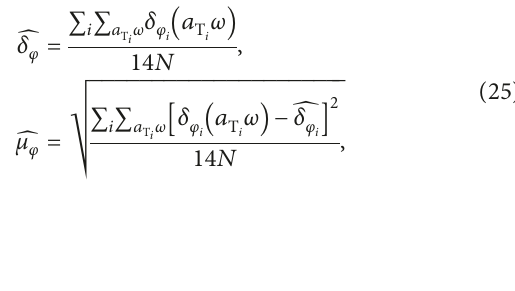
G (c) and absolute error for φ (d). Bold lines represent 10% and 5 ° limits for, respectively, relative and absolute | | ∗